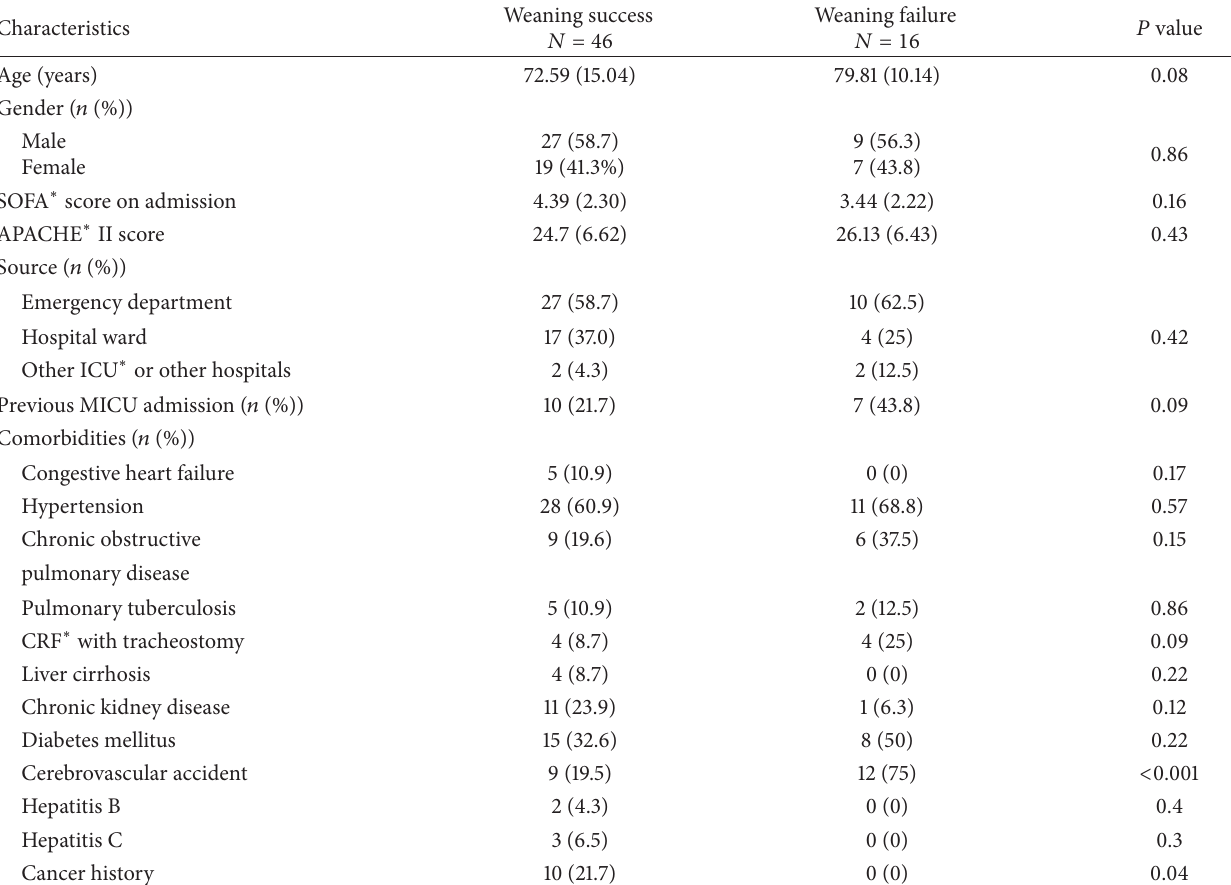
Table 7: Characteristics of patients with different weaning outcomes: bivariate analysis #